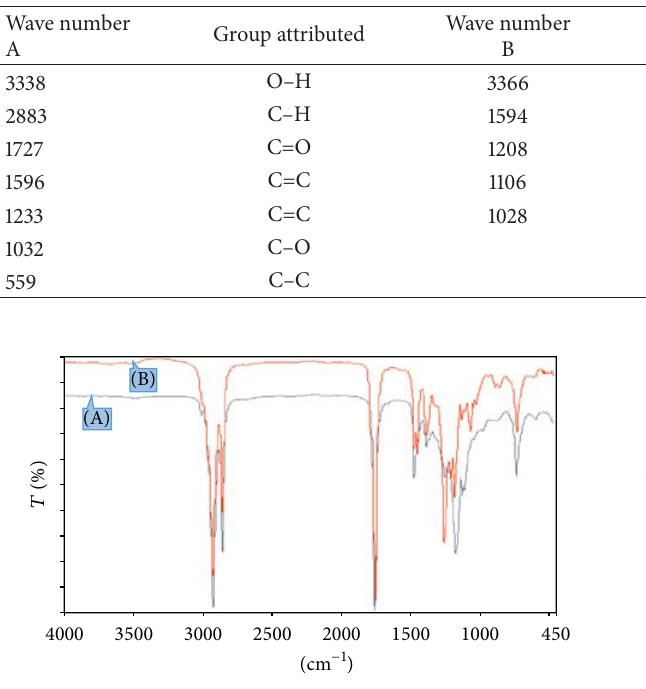
Figure 7: Raw FTIR spectra for expired sunflower oil (A) and biodiesel (B).